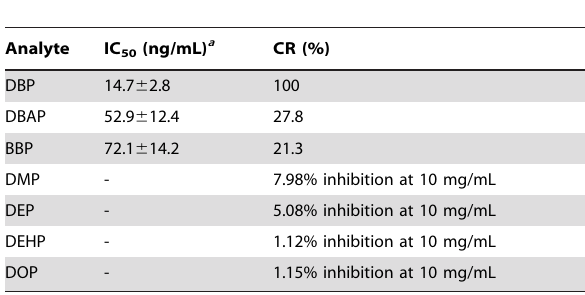
Table 5. Cross-reactivity of some compounds structurally related to DBP by hapten coated